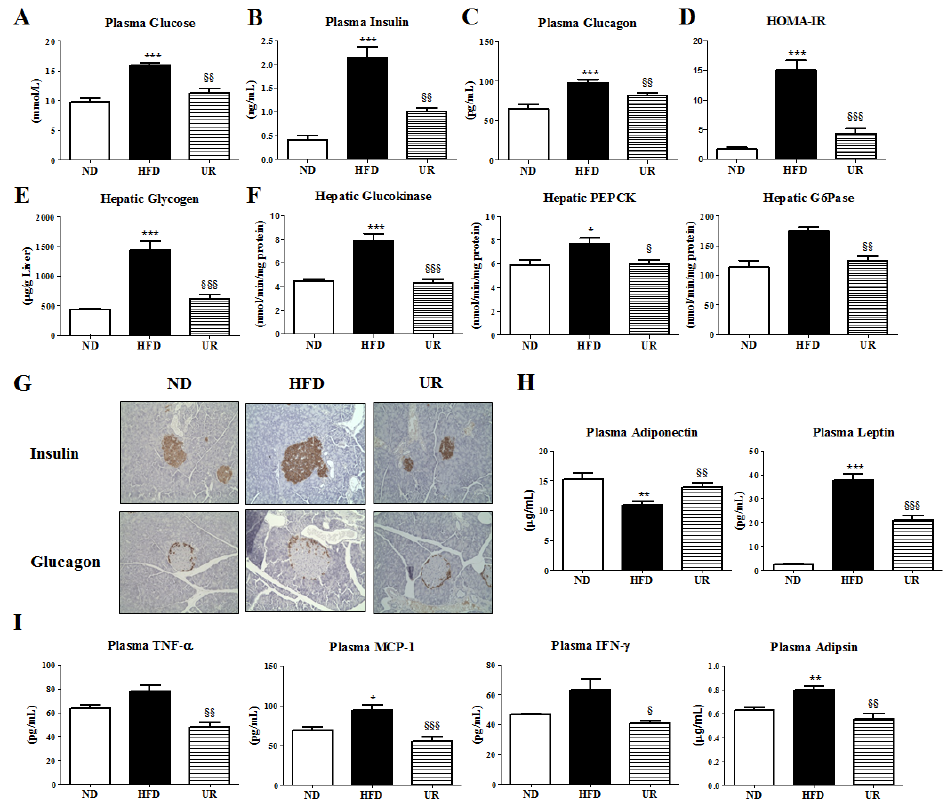
Figure 4. Effect of ursolic acid (UR) treatment on: plasma glucose level ( A ); insulin level ( B ); glucagon level ( C ); homeostasis model assessment-estimated insulin resistance (HOMA-IR) index ( D ); hepatic